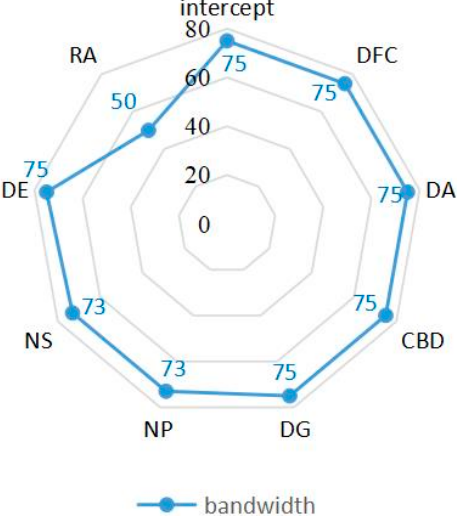
Figure 8. Bandwidths for influencing factors in the MGWR model.